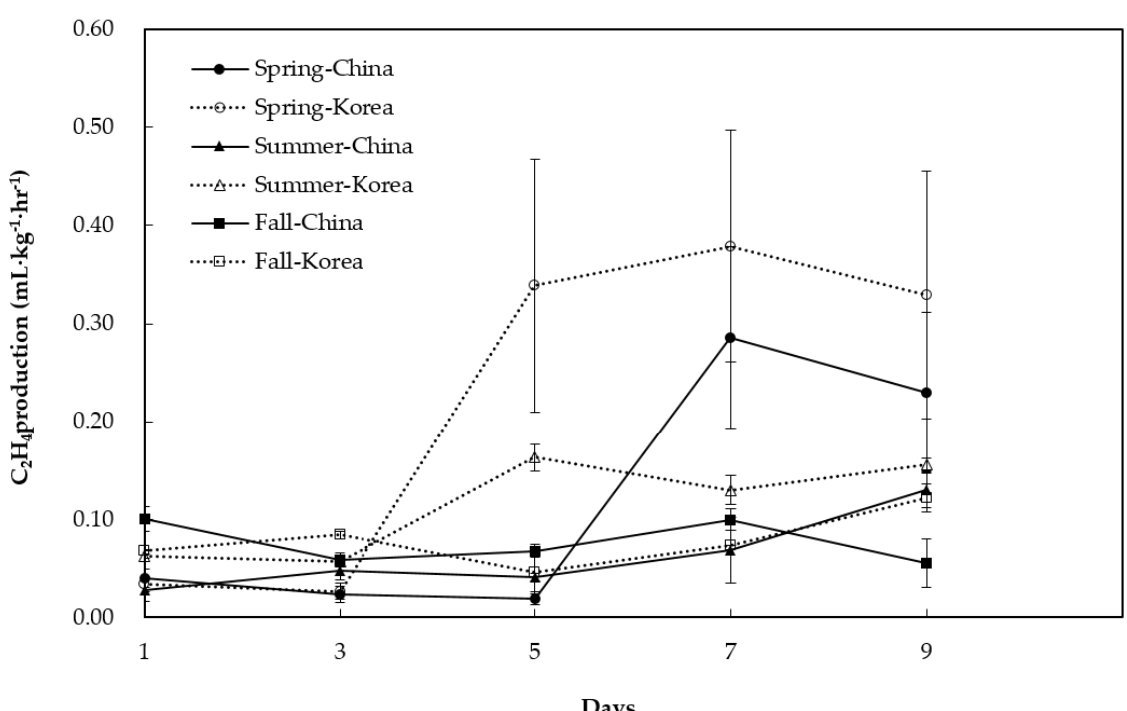
Figure 4. Changes in ethylene production of cut Phalaenopsis “V3” flowers based on the place of origin and season. The flower color changed, based on the Hunter values L, a, and b, on day 1 of the experiment and at senescence, the L value was high due to the white color of the “V3” cultivar (Table 2), with significant seasonal differences based on slightly higher L values in spring; however, no effect of the country of origin was observed. The L value on day 7 of the experiment was lower than that on day 1, except in autumn. The difference was particularly high in spring, which was in line with the results regarding the senescence type; wilting alone without browning led to senescence in autumn whereas browning occurred in spring (Table 1). The changes in L, a, and b values and chromaticity were found to vary significantly between seasons, rather than between countries of origin. Table 2. Hunter value L, a, b, and changes of petal